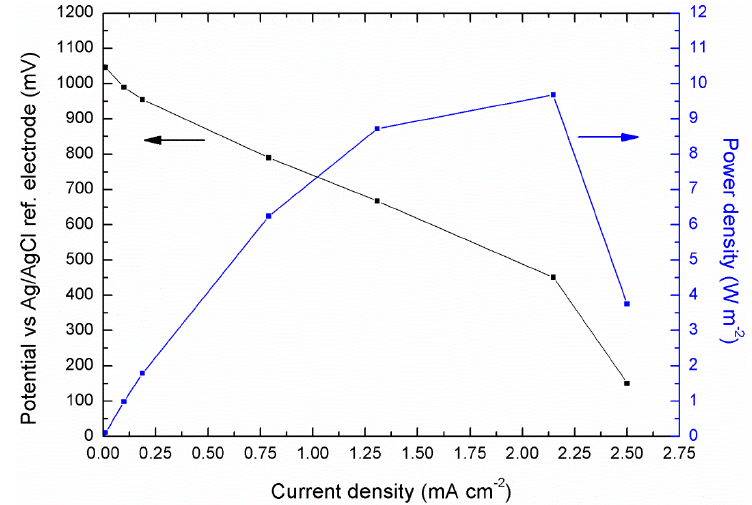
Figure 6. Cell potential and electric power density provided by the MFC at steady state (batch operation mode).